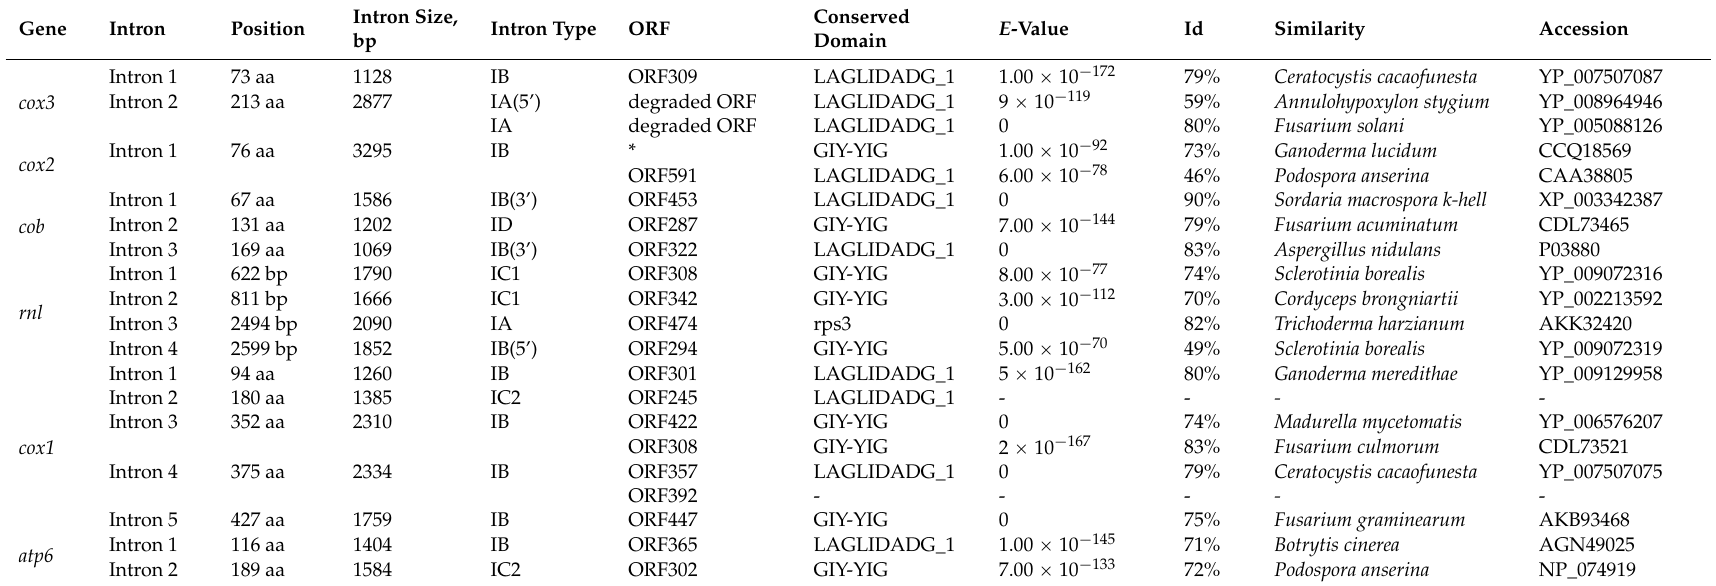
Table 1. Information of